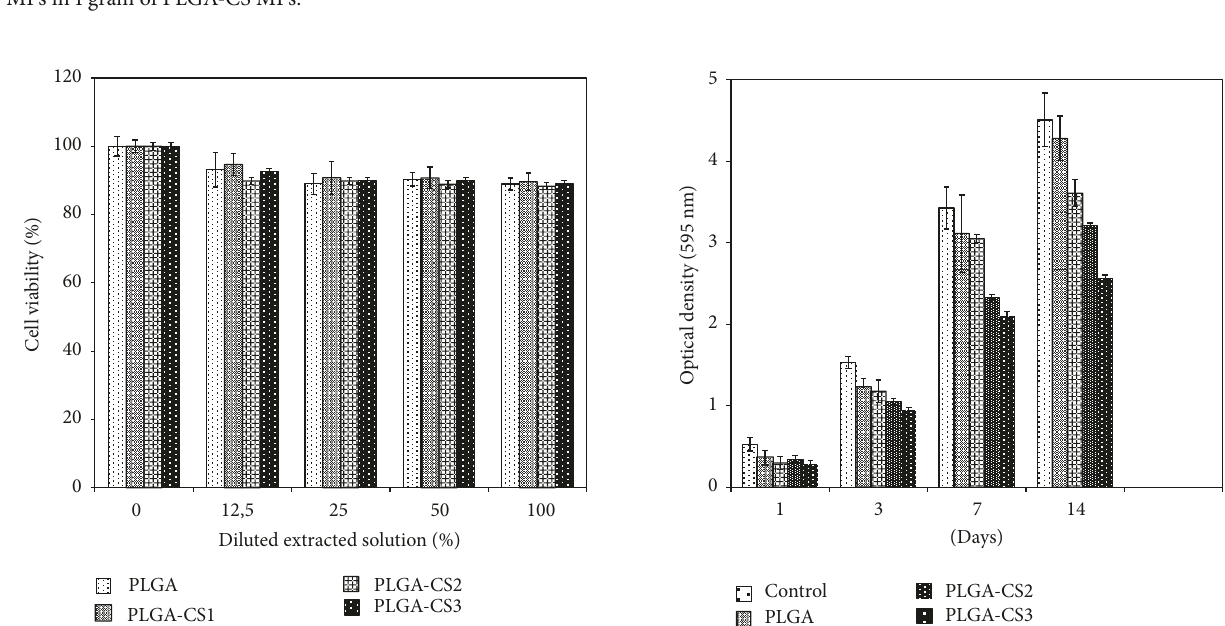
Figure 5: Series of images of fluorescein-labeled chitosan coating PLGA was visualized by confocal laser scanning microscopy (a–d). Microscope observation of PLGA MP (e) and PLGA-CS2 MP (f) immersed in distilled water for 24 hours. Mass of chitosan coated PLGA MPs in 1 gram of PLGA-CS MPs.